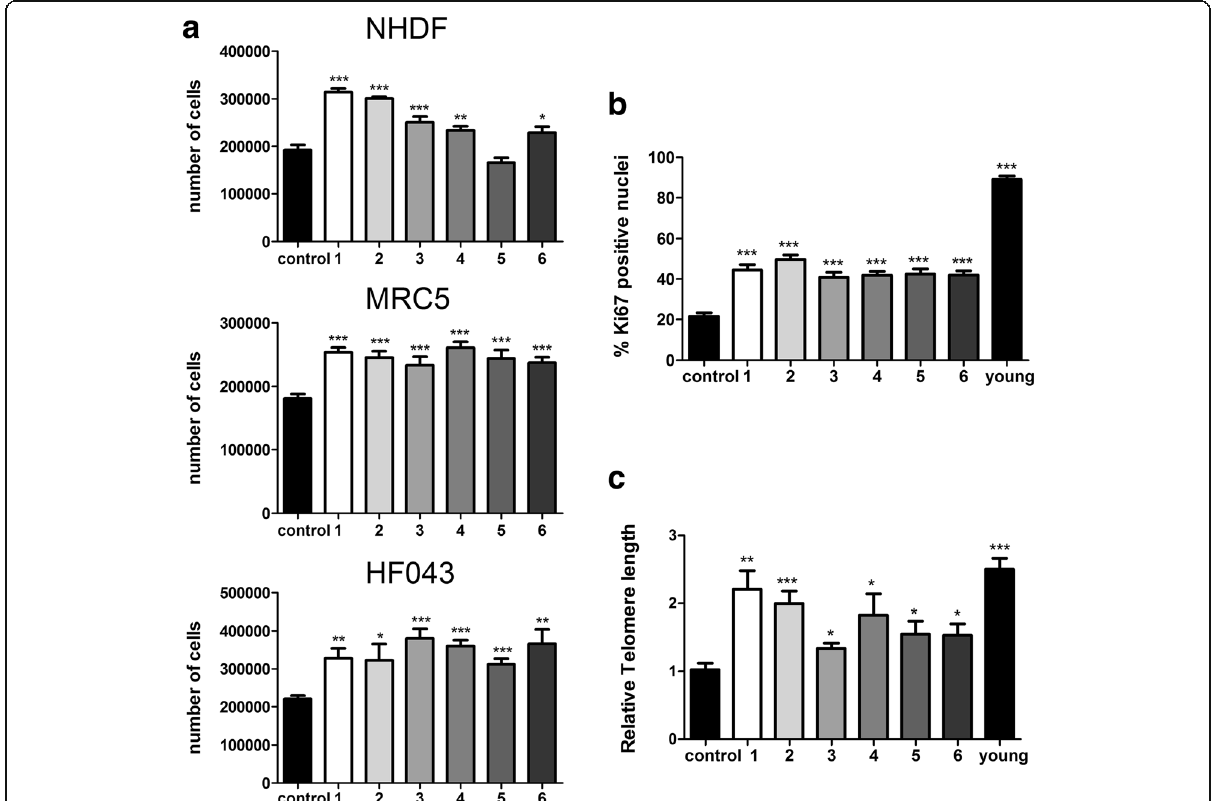
Fig. 5 Increased proliferation of senescent cell populations following resveralogue treatment. a Cell numbers of NHDF, MRC5 and HF043 fibroblast populations following treatment with resveralogues 1 – 6 . Experiments were carried out in triplicate for three biological replicates and *** represents p < 0.001 (2 way ANOVA). b Proliferation index was assessed for control and treated NHDFs, as well as younger (PD25) cells as assessed by Ki67 immunofluorescence (> 400 nuclei counted per sample, *** p < 0.001 by 2 way ANOVA). c Telomere length was quantified by qPCR relative to the 36B4 endogenous control and normalised to telomere length in vehicle-only controls, younger passage cells (PD25) and in cells treated with compounds 1 – 6 . Experiments were carried out in triplicate for three biological replicates. Statistical significance is indicated